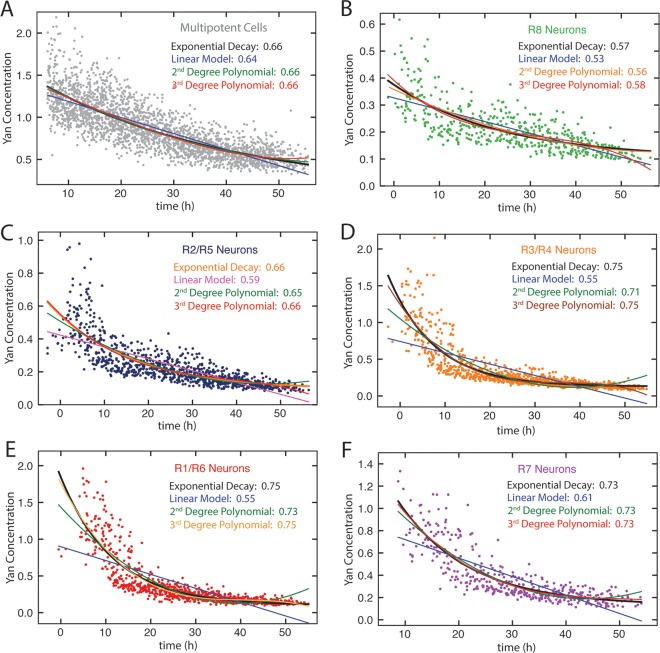
Model fitting Yan-YFP decay in eye disc cells.(A) Progenitors, (B) R8 cells, (C) R2 and R5 cells, (D) R3 and R4 cells, (E) R1 and R6 cells, (F) R7 cells. For each dataset, four models are shown: linear, exponential, second-order polynomial, and third-order polynomial. R squared values are indicated for each model.